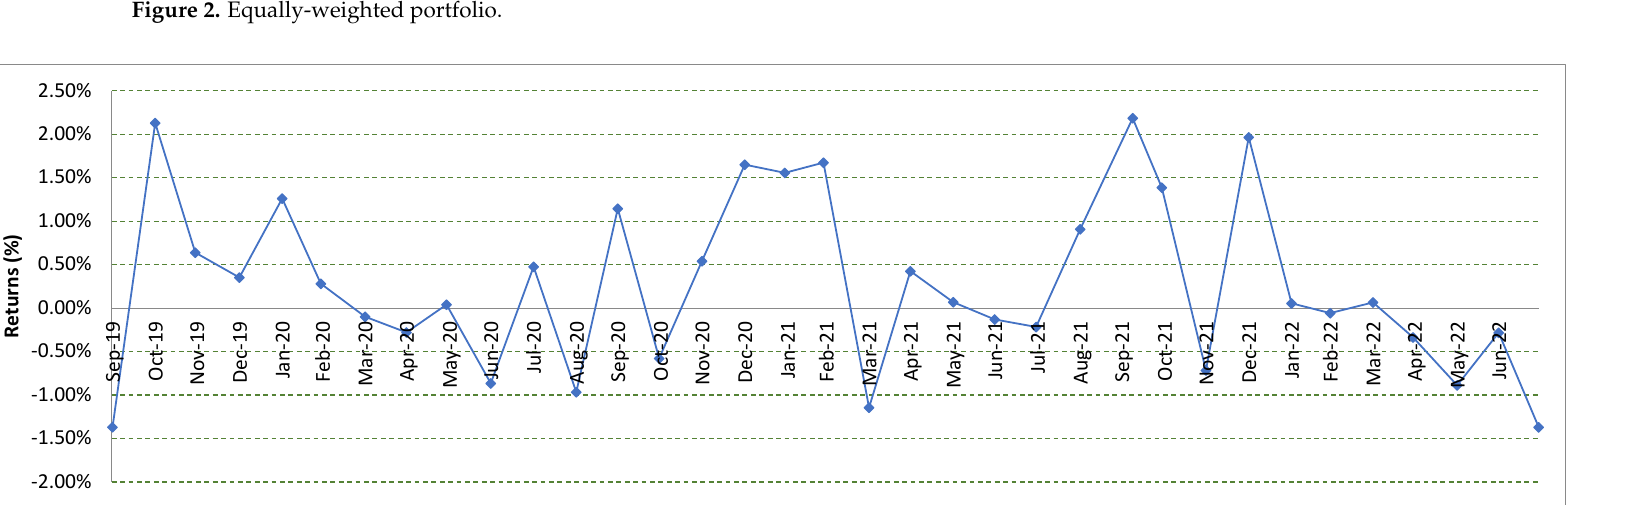
Figure 2. Equally-weighted portfolio.